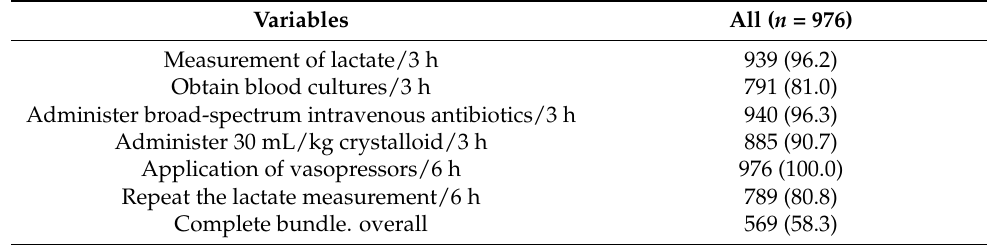
Table 1. The 3 h and 6 h elements and compliance of sepsis bundle for patients with septic shock.